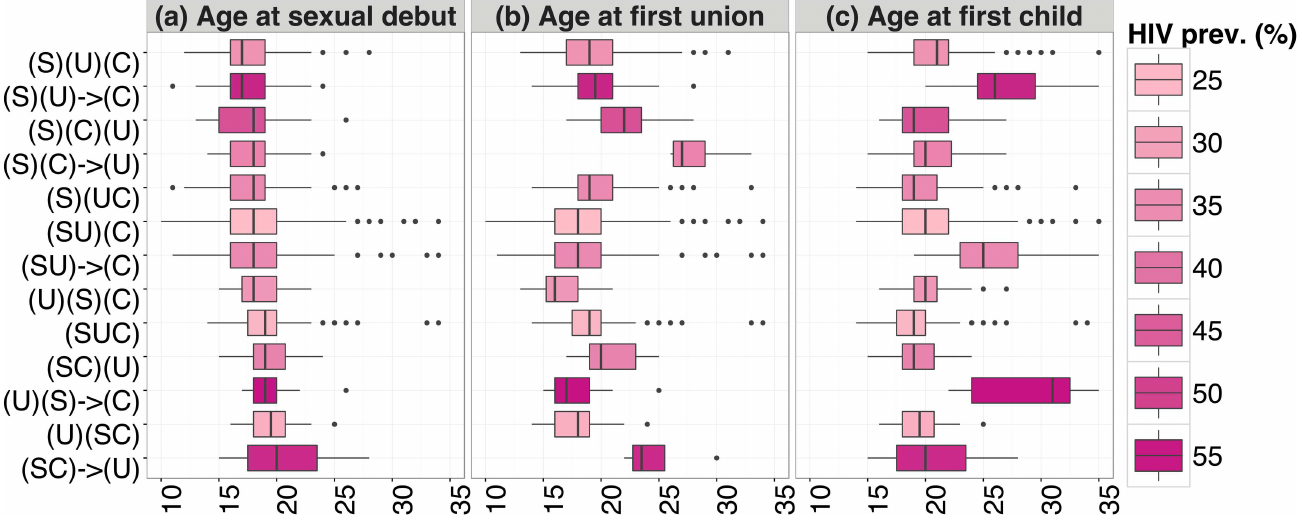
Fig 1. Age at events by sequence and HIV prevalence for women. Boxplot of the age at sexual debut, age at first union, and age at first child, by sequence,sorted by median age at sexual debut (in ascendingorder) and colouredaccordingto the HIV prevalence, Manicaland (Zimbabwe), 2000–